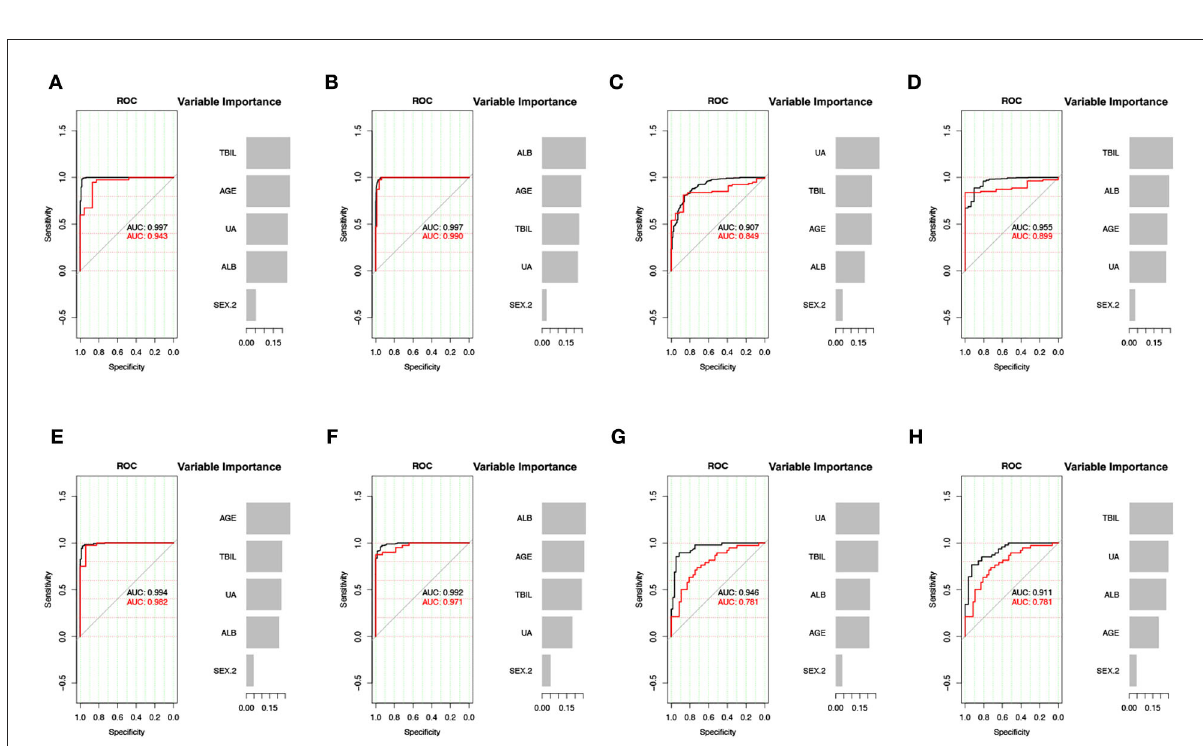
FIGURE3 XGBoost model for the predictive effect of non-enzymatic antioxidants. (A–D) The result of discovery data. (E–H) The result of validation data. (A,E) BD vs. HC. (B,F) MDD vs. HC. (C,G) BD vs. MDD. (D,H) BD-D vs. MDD. UA, uric acid; ALB, albumin; TBIL, total bilirubin; BD, bipolar disorder; MDD, major depressive disorder; BD-D, bipolar disorder with depression episode; HC, healthy control; ROC, receiver operating characteristic curve; AUC, area under the curve.